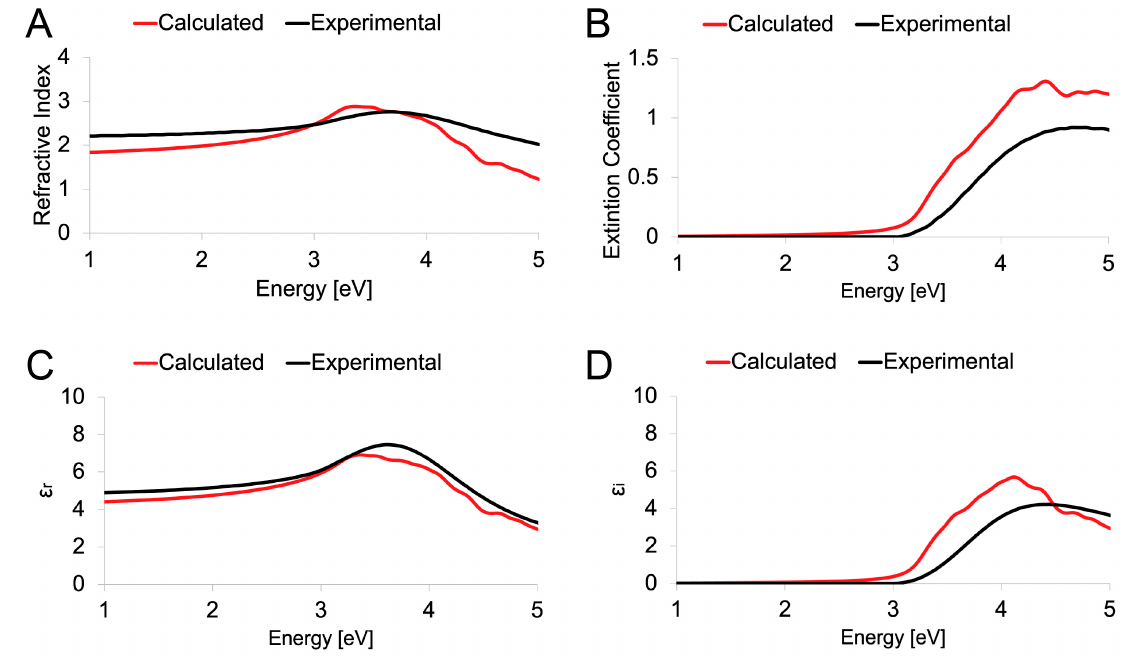
Figure 7. Calculated (red) and Experimental (black) optical spectra of orthorhombic MoO 3 . Refractive index ( A ), extinction coefficient ( B ), real part ε r ( C ), and imaginary part ε i ( D ) of the dielectric constant reported as a function of the energy.